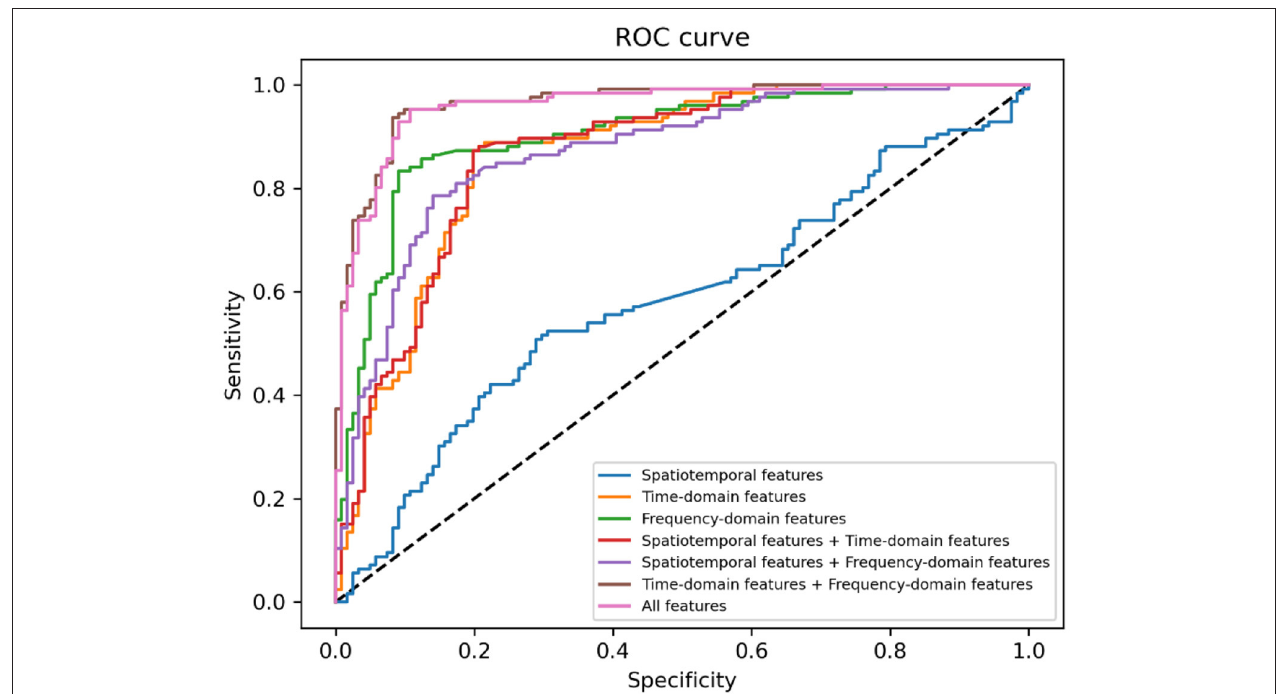
FIGURE 5 | Receiver operating characteristics (ROC) curve for different machine learning methods.